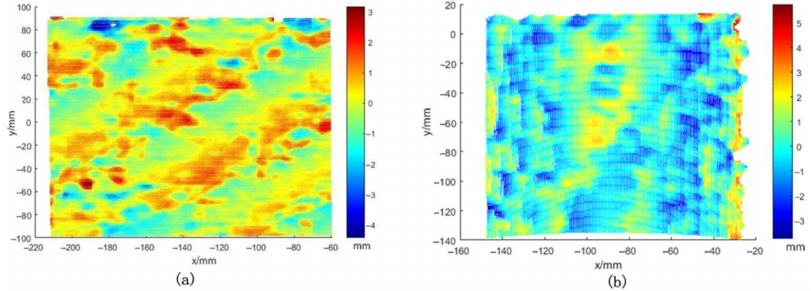
Figure 12. Evaluation of depth accuracy using the fitting method. ( a ) Error map of plate, ranging from − 4.4 to 3.2 mm; ( b ) Error map of the column, ranging from − 3.8 to 5.7